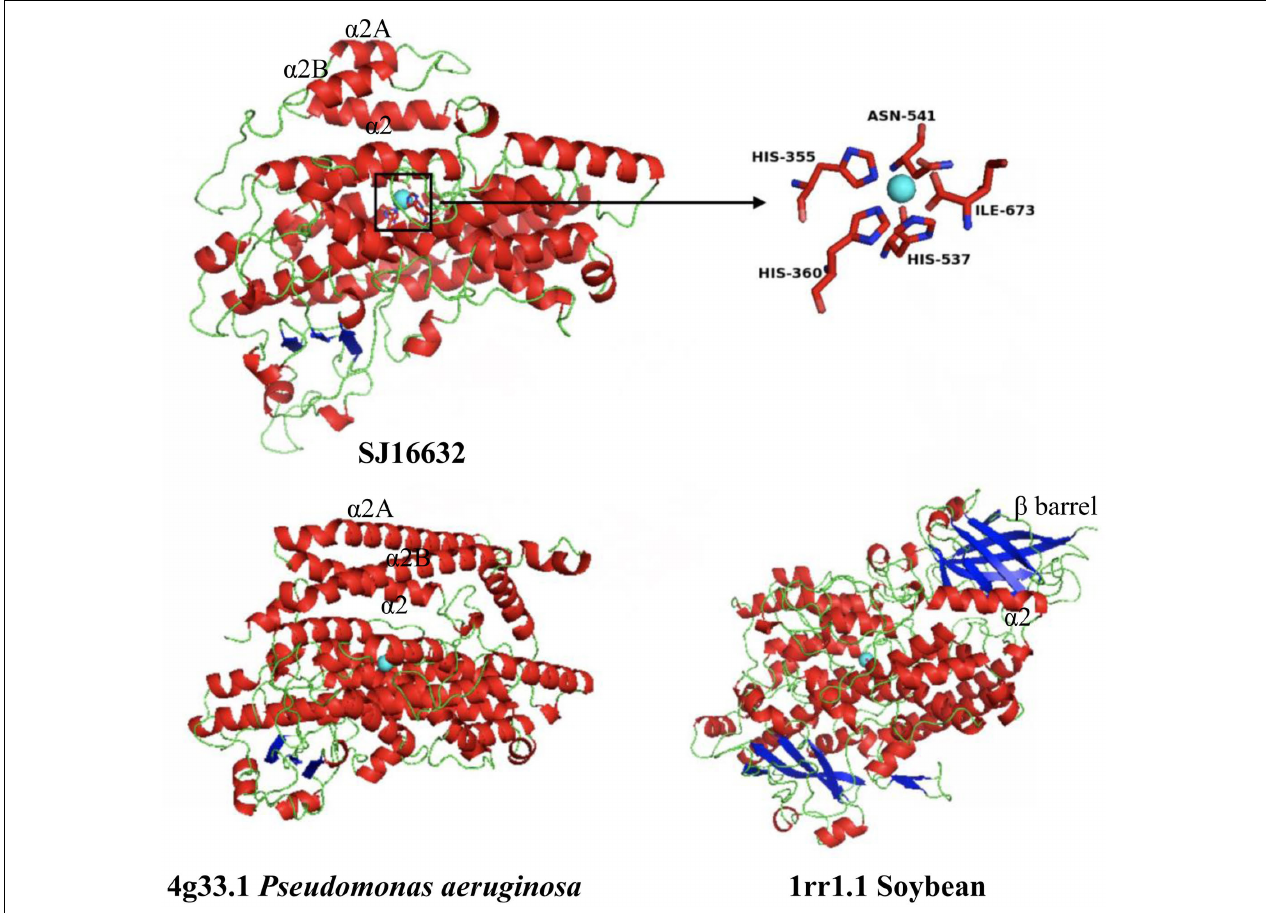
FIGURE 9 | Modeled 3D structure of the S. japonica LOX protein (SJ16632) and the 3D structure of P. aeruginosa and soybean. Blue sphere: non-heme iron; inset: the predicted active site for binding